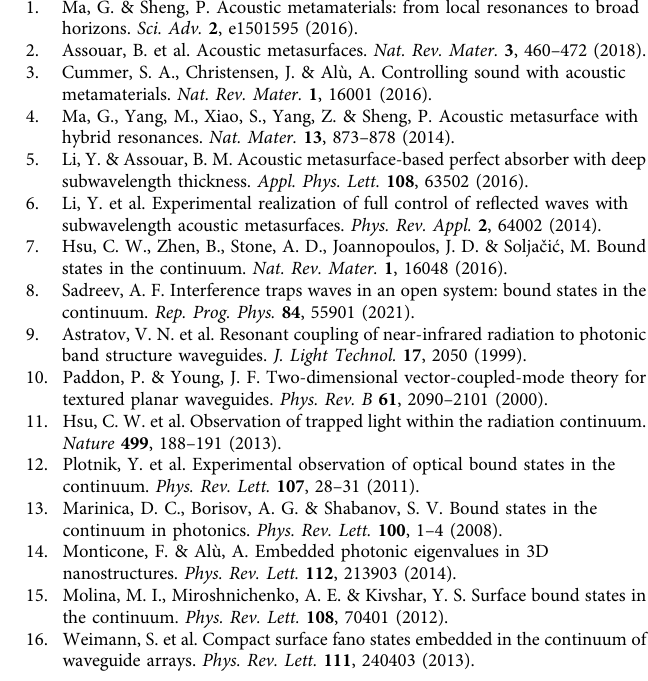
Fig. 5 Q -factor of QBIC. a Measured Q -factor of modes A (M 121 ) and B (M 221 ) for the half resonator and full resonator as a function of y c . b Measured Q -factor of modes A (M 131 ) and B (M 113 ) for full resonator as a function of size ratio. c Measured as a function of size ratio. d Calculated Q -factor of modes A (M 121 ) and B(M 221 ) for the half resonator and full resonator as a function of y c . e Calculated Q -factor of modes A (M 131 ) and B (M 113 ) for full resonator as a size ratio function. f Calculated as a size ratio